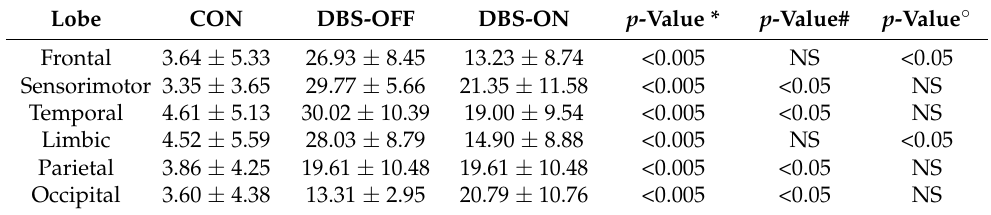
p ‐ Values * indicates a comparison between control group and PD DBS ‐ OFF; p ‐ Value# indicates a comparison between control group and PD DBS ‐ ON; p ‐ Value° indicates a comparison between PD DBS ‐ OFF and DBS ‐ ON. NS: Not significant difference.